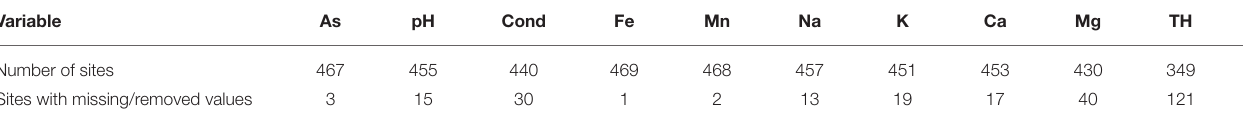
TABLE 1 | Site numbers for each variable (total sites 470). Variable As Number of